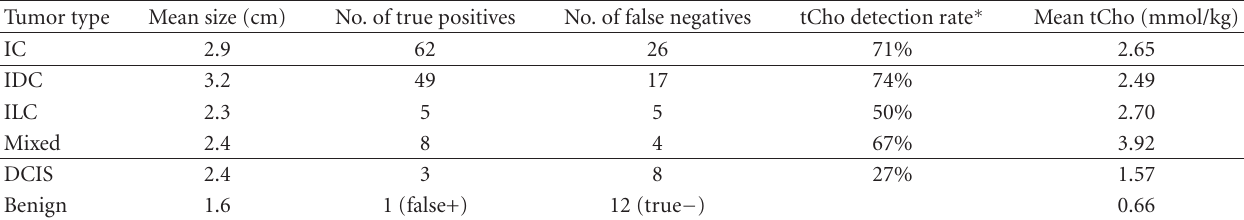
Tumor size (cm) was calculated by taking the square root of the product (e.g., the longest dimension × the longest perpendicular dimension of the maximum intensity projection (MIP) of the MR subtraction images). ∗∗ P < 0 . 0002, where the significance level was set at P < 0 . 05. There is no significant group di ff erence in tCho level ( P > 0 . 05). Table 2: Summary of tumor size, tCho detection rate, and tCho concentration level in histopathological types. Tumor type